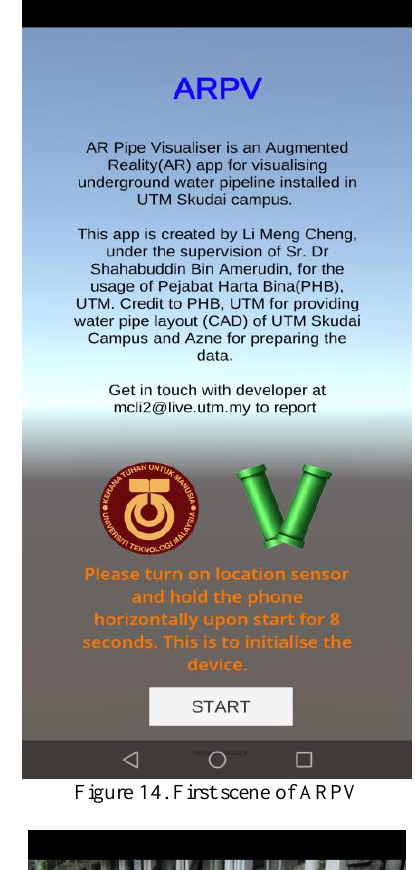
Figure 14. First scene of ARPV